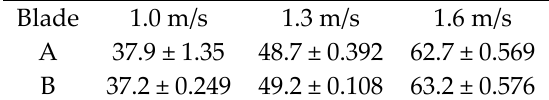
Figure 5. Experimental results of the displacement response about the x axis: ( a ) blade A; ( b ) blade B. The black, red and blue lines represent the results at impact speeds of 1.0, 1.3 and 1.6 m/s, respectively. Table 3. The average and standard deviation of the maximum displacement (unit: